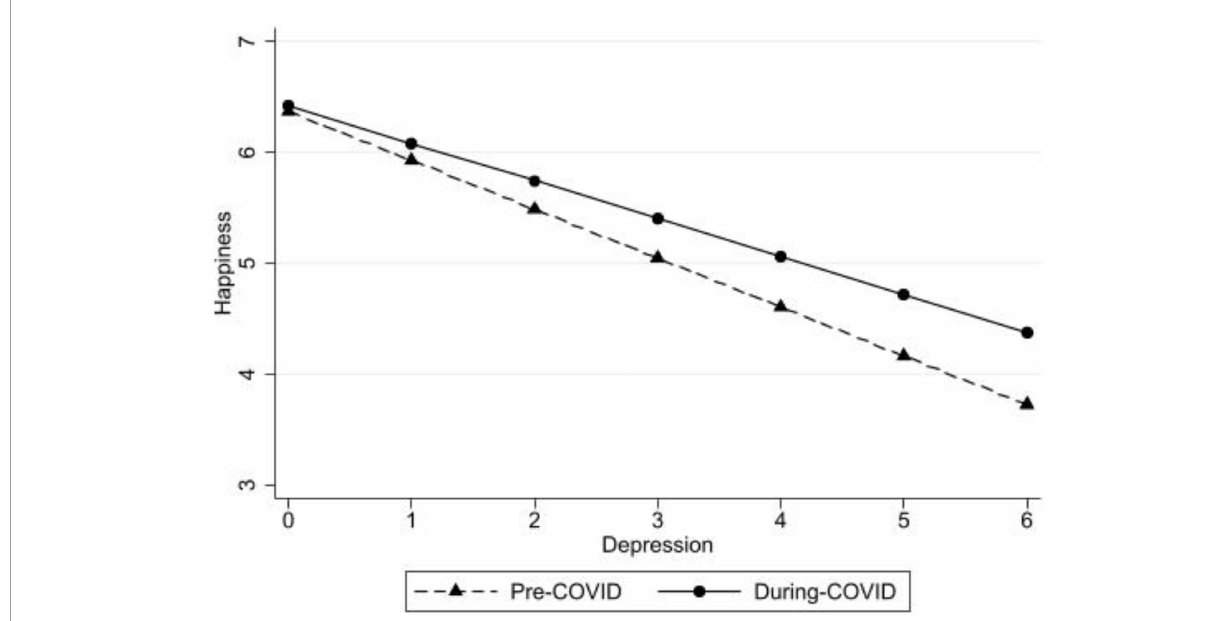
FIGURE3 Depression symptoms predicting happiness pre- and post- the COVID-19 pandemic declaration with the follow-up sample.